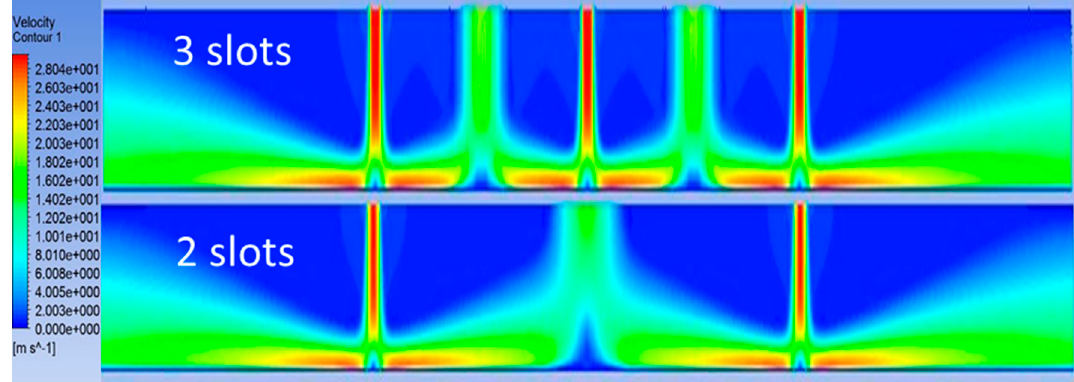
Figure 11. Velocity contours of multi slot jet configuration with H/B = 4, Re = 5500 and realizable k- ε model: three slots ( upper ) and two slots ( down ).